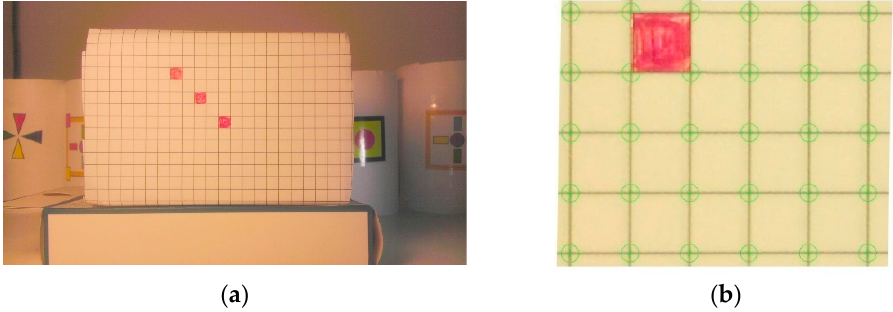
Figure 10. Experimental determination of correspondence curve. ( a ) Graph paper used; ( b ) feature recognition based on the method.